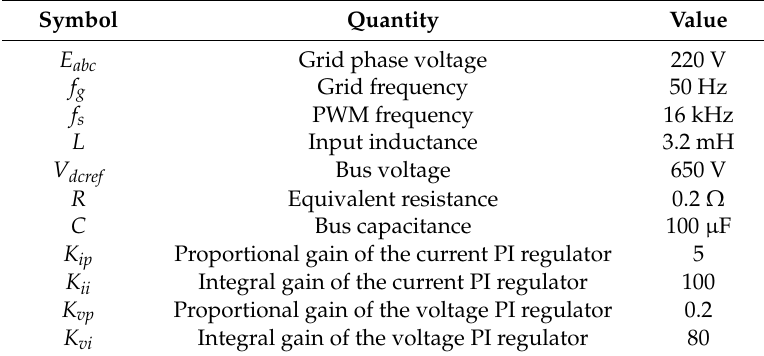
Table 1. Circuit Parameters of the Three-phase VSR.